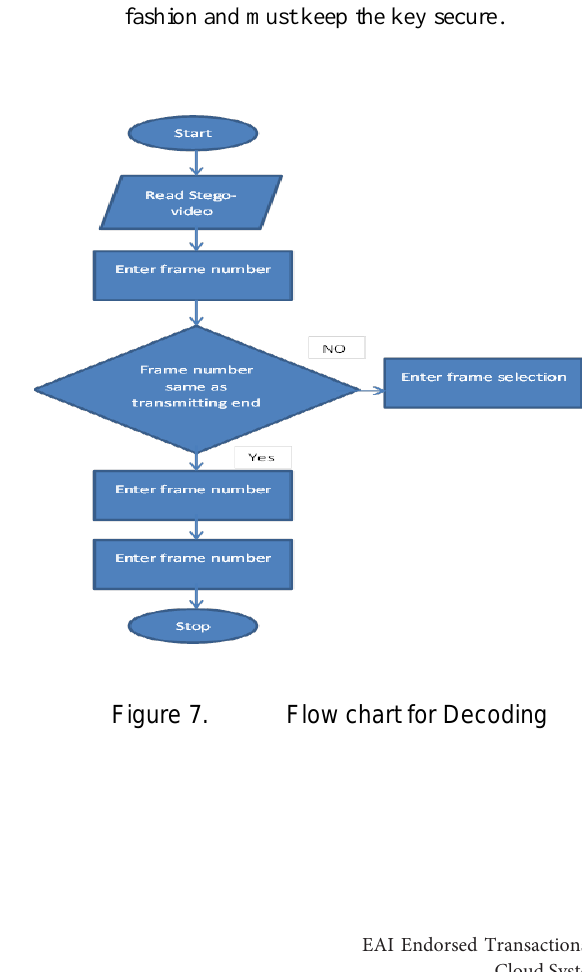
Figure 6. Flow chart for Encoding